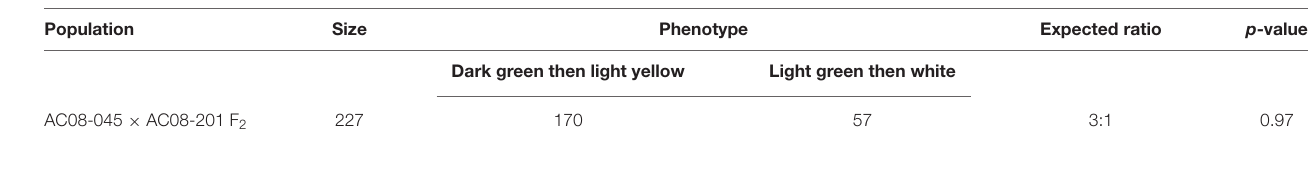
TABLE 2 | Segregation of phenotypes in a F 2